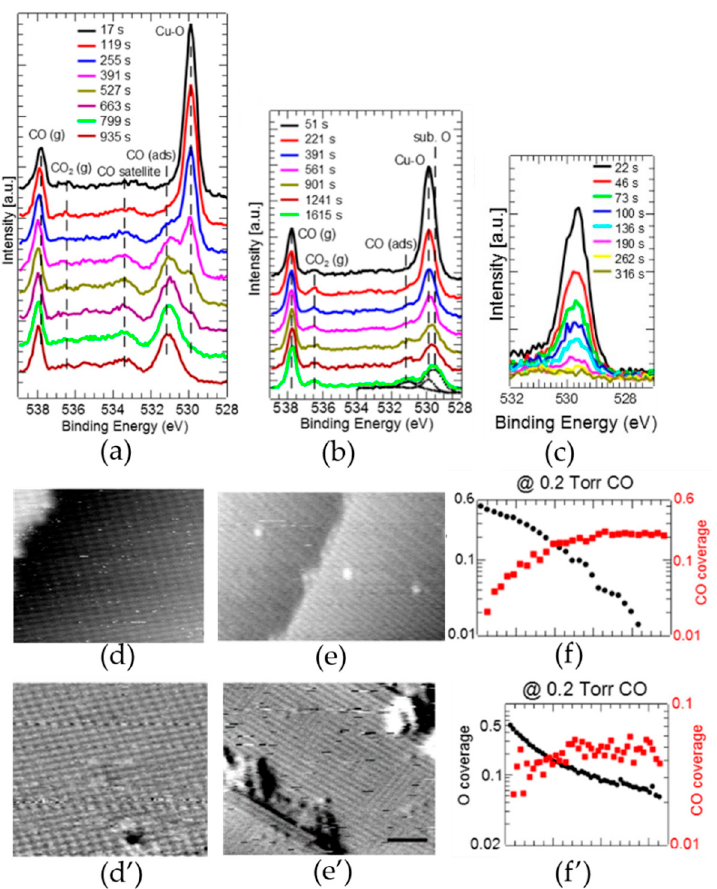
√ 2 × √ √ √ 2 × 2R45 ◦ )-O surface at RT ( e ) in √ √ 2 × 2 R45 ◦ )-O